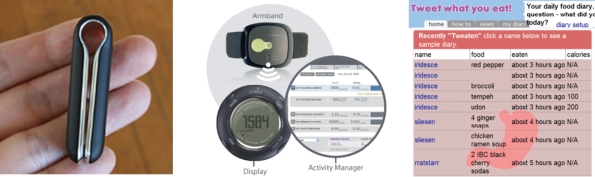
Quantified self-tracking tools: FitBit, GoWearFit and Tweet what you eat!